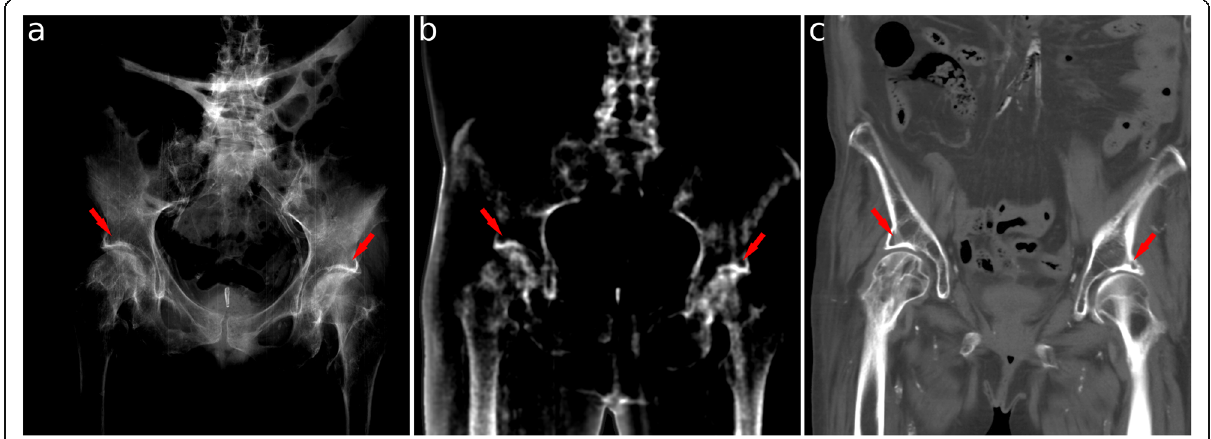
Fig. 2 Conventional x-ray (window level 4.05, window width 1.1) ( a ) and dark-field radiograph (window level 0.8, window width 2.0) ( b ), and coronal computed tomography reconstruction ( c ) of the pelvic region. The red arrows mark an area with subchondral sclerosis as a cause of bilateral osteoarthritis of the hips. These areas exhibit an increased signal at both modalities. Whereas the increased attenuation signal is due to the associated thickening of the bone structure, the increased dark-field signal can be attributed due to spectral hardening effects as well as increased small-angle